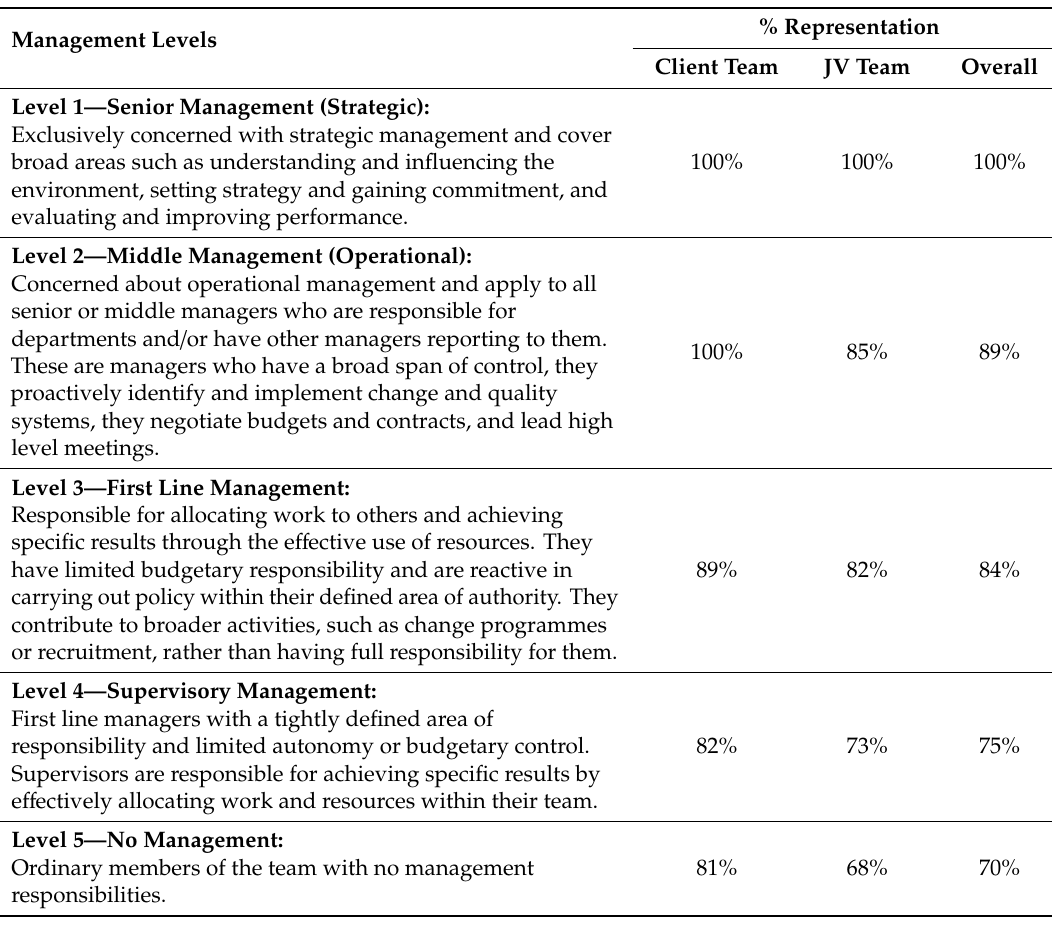
Table 2. The distribution of survey responses across the population, categorized according to five broad levels of management